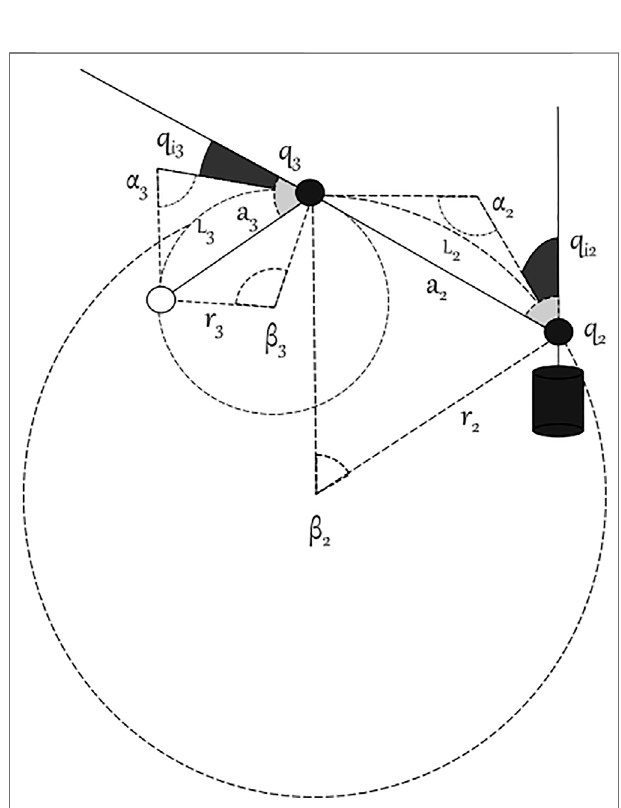
FIGURE 4 | Details of a bended MUSHA fi